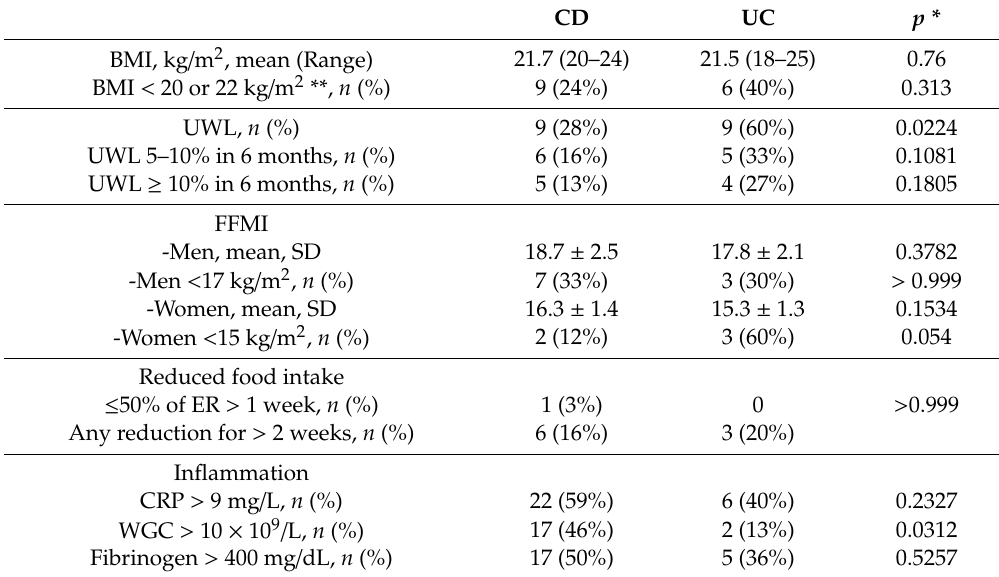
Table 3. Prevalence of Phenotypic and Etiological criteria in IBD patients. CD